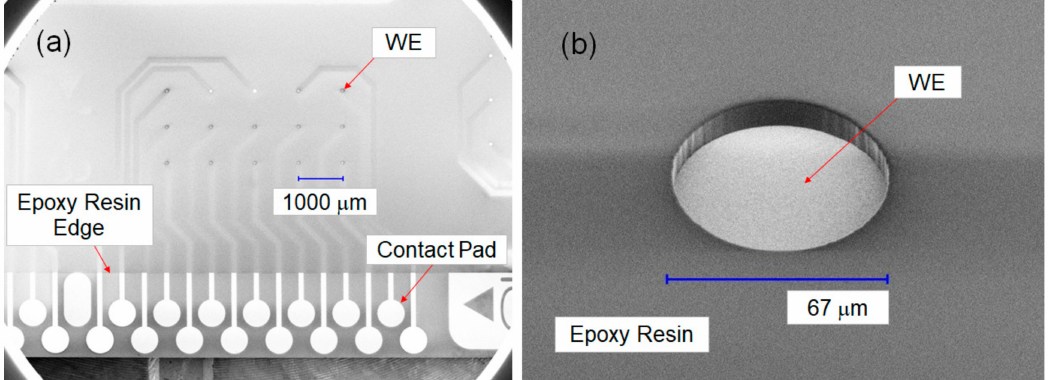
Figure 1. ( a ) SEM image of one block of the microelectrode array chip, which contained 15 pieces (pcs) of working electrodes (WEs) (top view, ∅ 67 µ m). ( b ) SEM image of a single WE (45 ◦ tilted view, ∅ 67 µ